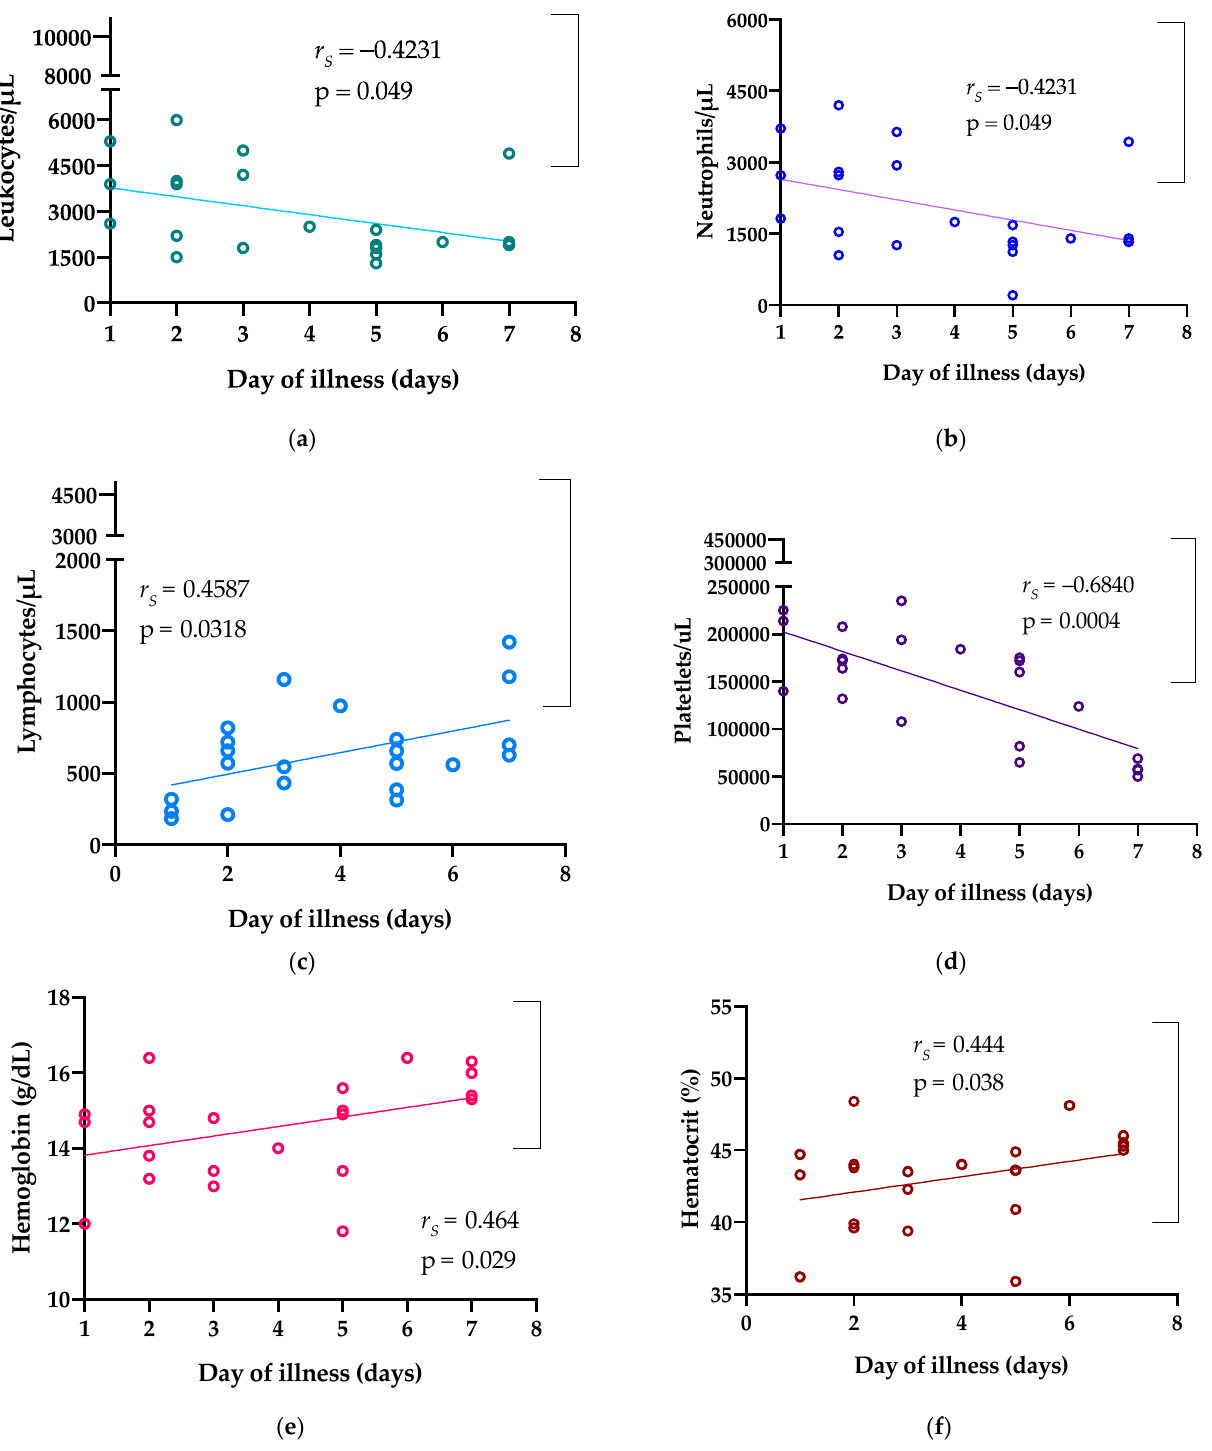
Figure 1. Spearman’s correlation analysis of hematological profile kinetics during the acute phase. Trends observed with leukocytes ( a ), neutrophils ( b ), lymphocytes ( c ), platelets ( d ), and hemoglobin ( e ) and hematocrit ( f ) levels. Normal ranges of parameters are shown in square brackets.